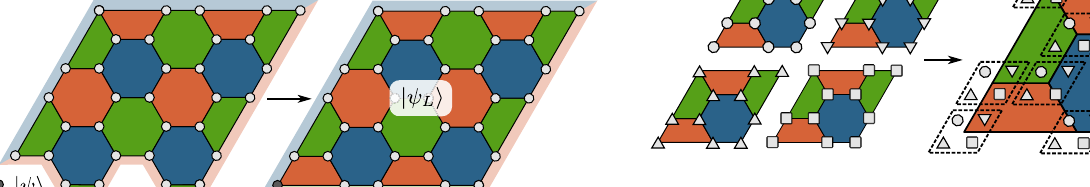
FIG. 13. Inflation protocol for transversal multitarget . First, the L i